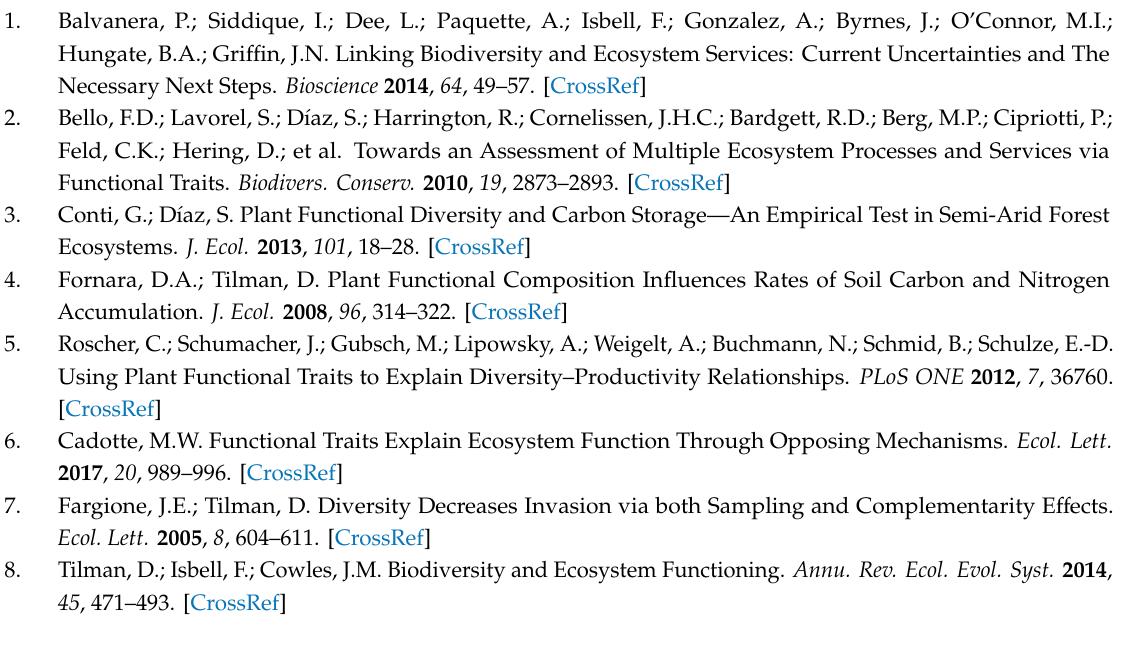
Figure S1: Functional classification for a set of 54 grassland plant species by trait similarity into three functional groups. Figure S2: Regression analysis for the functional dispersion and functional redundancy indexes [28,52]. The figures show the functional dispersion index ( a ) and the functional redundancy index ( b ) according to the number of functional groups composing the experimental communities and the correlation between functional dispersion and functional redundancy ( c ). Figure S3: E ff ects of functional dispersion on Solidago plants emergence and aboveground biomass. Figure ( a ) shows S. gigantea emergence, while ( b ) represents results for S. gigantea biomass varying according to the functional dispersion index. Aboveground biomass was collected at the end of the experiment (16 weeks), while emergence was evaluated during the second week of the experimental period for each one of the communities, invaded or not. For the dependent variables, F-values are presented in the text (*** p ≤ 0.001; ** p ≤ 0.01; * p ≤ 0.05; p ≤ 0.10; ns p > 0.10). Table S1: Functional trait characteristics for each functional group. Values of quantitative functional traits represent mean ( ± SD). Table S2: Functional trait characteristics of the native species occurring in the mesocosm communities used for the calculation of the functional dispersion index. Zero (0) and 1 values represent the presence / absence of categorical functional traits. Quantitative functional traits are represented by mean values for each species. Species relative abundances were determined by multiplying the 3 g m − 2 of native species sown (i.e., 0.48 g of seeds which means, approximately, 0.054 g for each one of the native species present) by its mean seed mass to obtain the number of seeds per native species. Mean seed mass information (given in mg) was obtained from BiolFlor database [48,49]. For the species Buphthalmum salicifolium L. we used the thousand seed mass obtained from Rieger-Hofmann GmbH (Catalogue 2016 / 2017) to calculate the mean seed